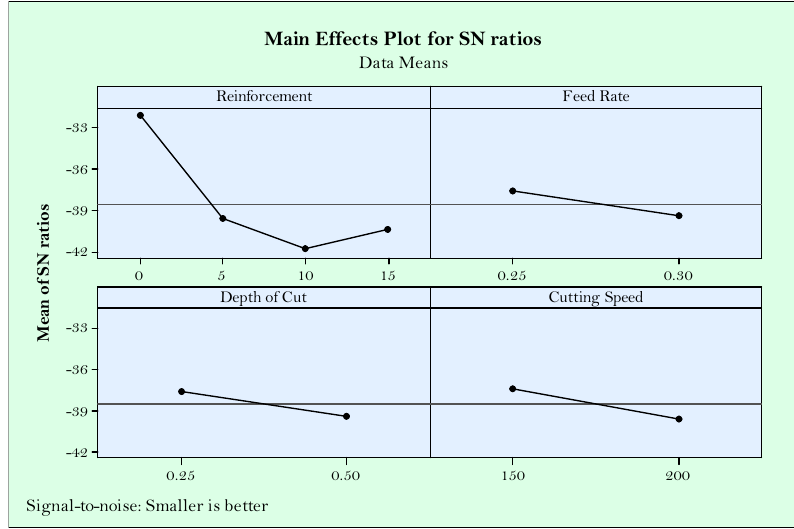
Figure 9. Main effect plots for S/N ratios of temperature.